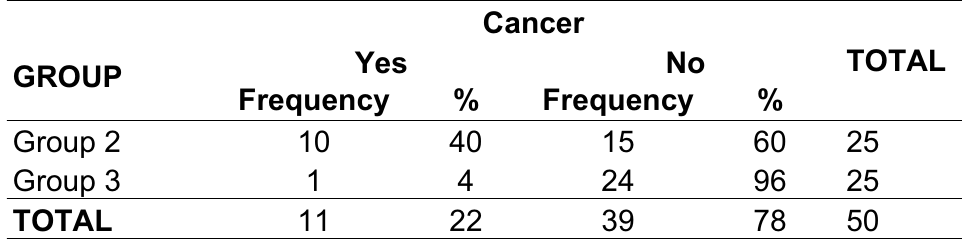
TABLE 1 – Analysis of the association between groups 2 and 3 in relation to the presence of